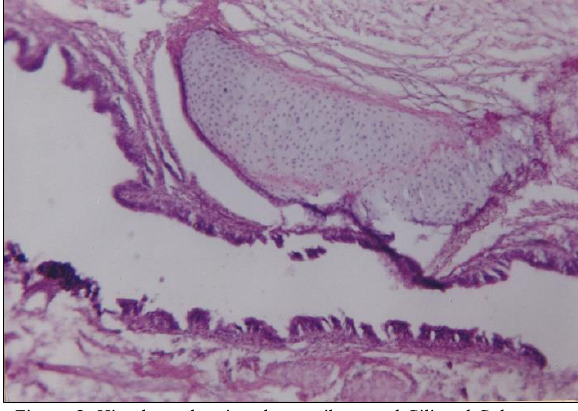
Figure 2: Histology showing the cartilage and Ciliated Columnar Epithelium. The cut section of the mass was homogenous, fleshy and there were a few areas of firm consistency. Figure 3: Hypothetical explanation based on the embryogenic error of frontonasal process overgrowth. (a) Normal development of frontonasal process; (b) overgrowth of the medial nasal processes; (c) Fusion of the elongated processes; (d) Partial regression of the base by apoptosis thereby causing the pedunculated